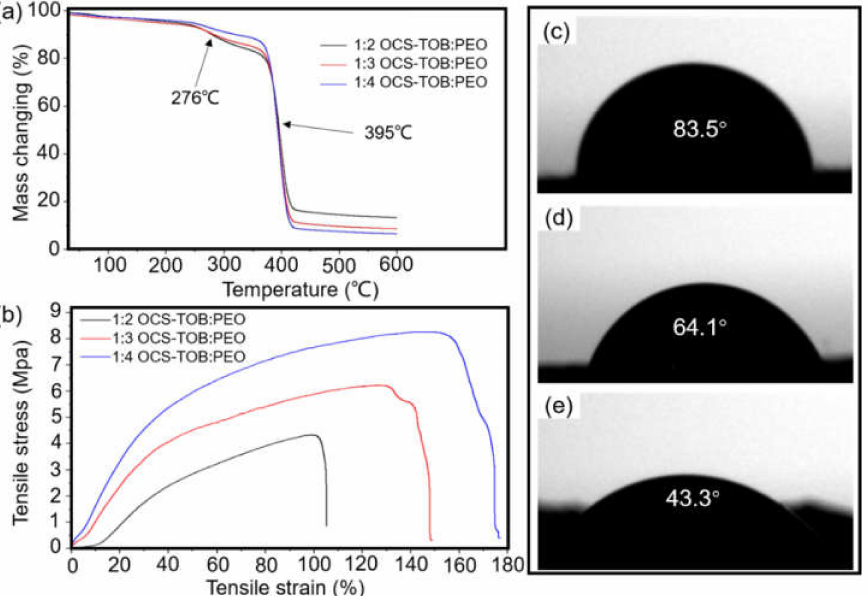
Figure 3. The TGA results of different ratios of OCS-TOB/PEO composite sub micro-fibers ( a ); mechanical test of the produced OCS-TOB/PEO sub micro-fiber yarn ( b ); the contact angle test of different ratios of OCS-TOB/PEO sub micro-fiber mats: 1:2 OCS-TOB/PEO ( c ), 1:3 OCS-TOB/PEO ( d ) and 1:4 OCS-TOB/PEO ( e